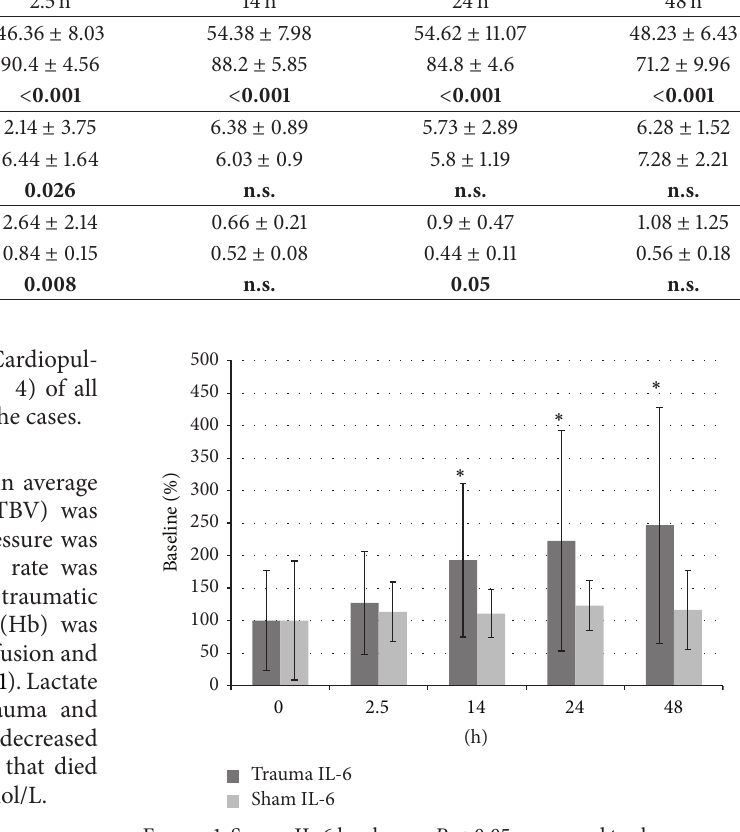
showed that HMGB1 significantly decreased over time (14 h versus 48 h: 𝑃 = 0.047 ) while HSP70